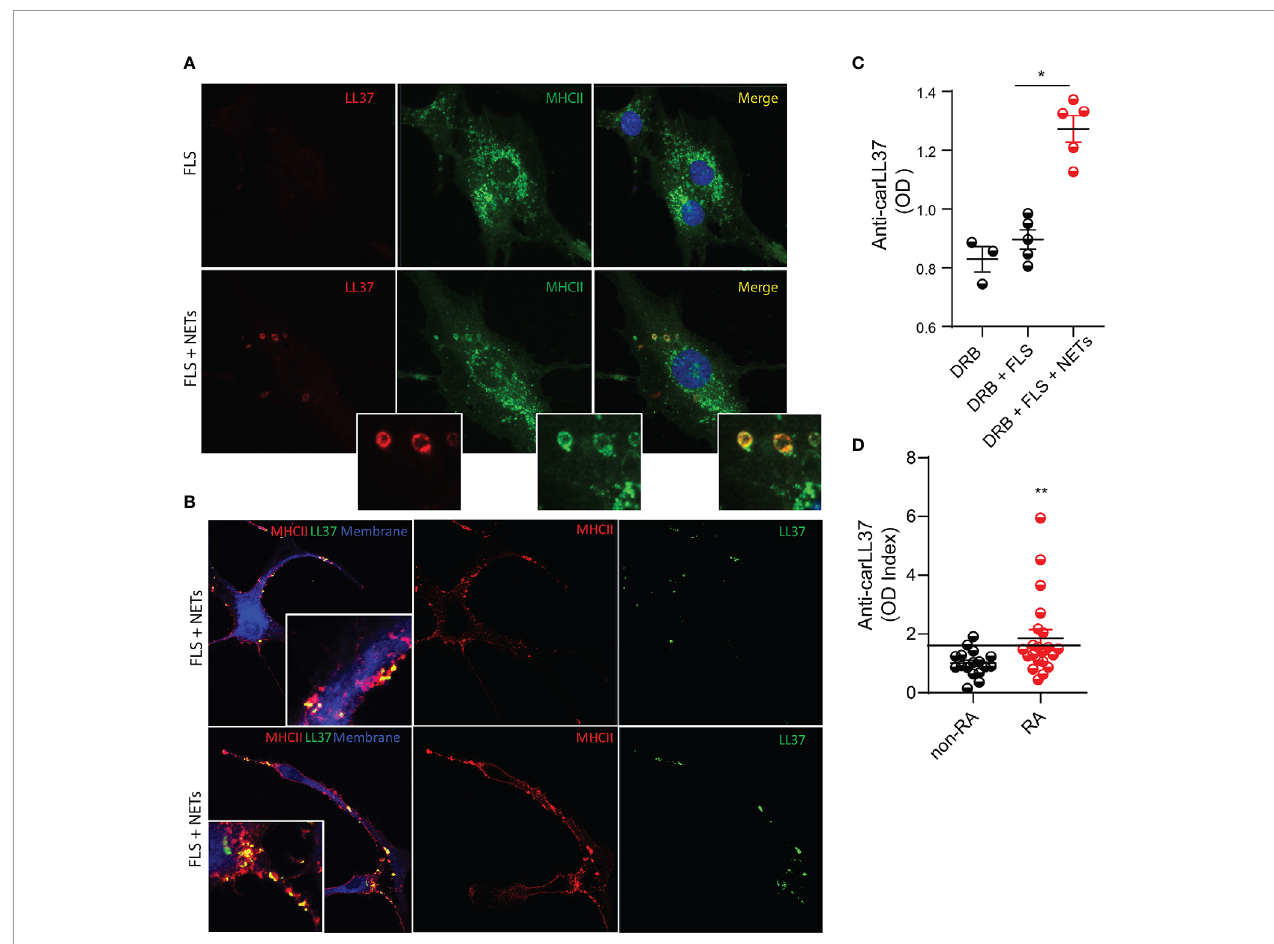
FIGURE 2 | FLSs internalize carbamylated LL37 and induce antigen-speci fi c autoantibody responses. NETs containing carbamylated LL37 were incubated with RA FLS for 24 hours. (A) Intracellular co-localization of carbamylated LL37 and MHCII was assessed in RA FLS. Red, LL37; green, MHCII; blue, DNA. (B) Co-localization of MHCII and LL37 was assessed in the plasma membrane of un permeabilized RA FLS after 48h incubation with NETs. Green, LL37; red, MHCII; blue, plasma membrane. Results are representative of three independent experiments. Original magni fi cation is 400X. (C) Serum samples from HLA-DRB1*04:01 transgenic mice immunized with FLS alone or FLS that internalized RA-NETs were analyzed for the presence of autoantibodies against carbamylated LL37. Results are the mean +/- SEM of n=3-5 per group. One-way ANOVA- Dunn ’ s multiple comparisons test was used. *p < 0.05. (D) Autoantibodies against carbamylated LL37 were measured in non-RA (n = 9) and RA (n = 15) synovial fl uid. Black line = 2 standard deviations above mean for non-RA patients. Results are the mean +/- SEM. Mann-Whitney U test was used. **p <